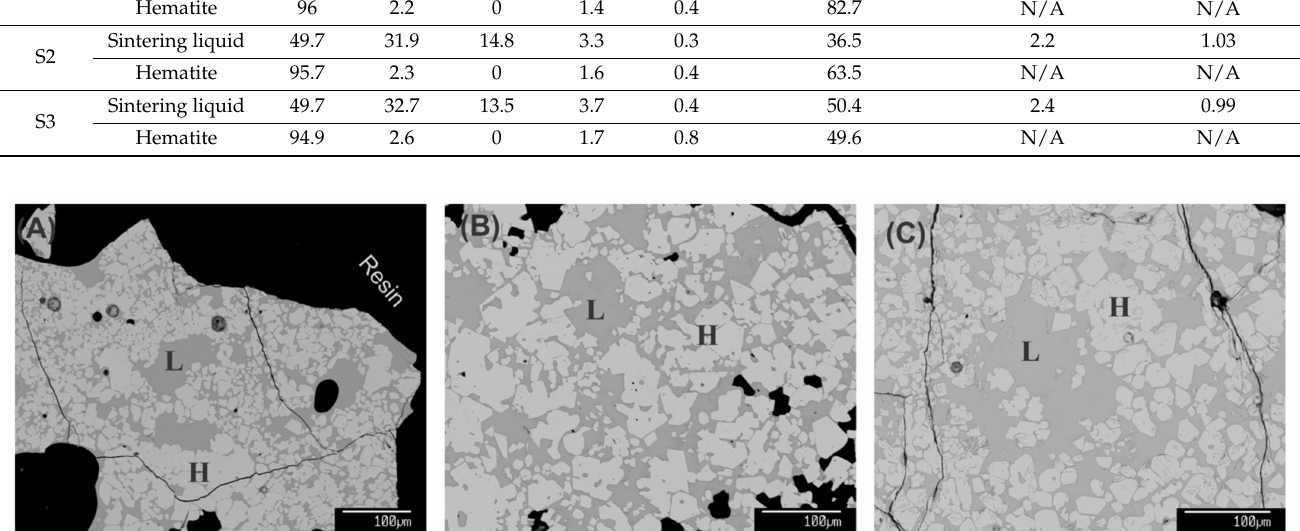
Figure 2. Microstructural BSE images of various reheated sinters quenched from 1300 ◦ C. Microstruc- ture ( A ) S1, ( B ) S2, and ( C ) S3. All samples comprise the hematite (H) and liquid phase